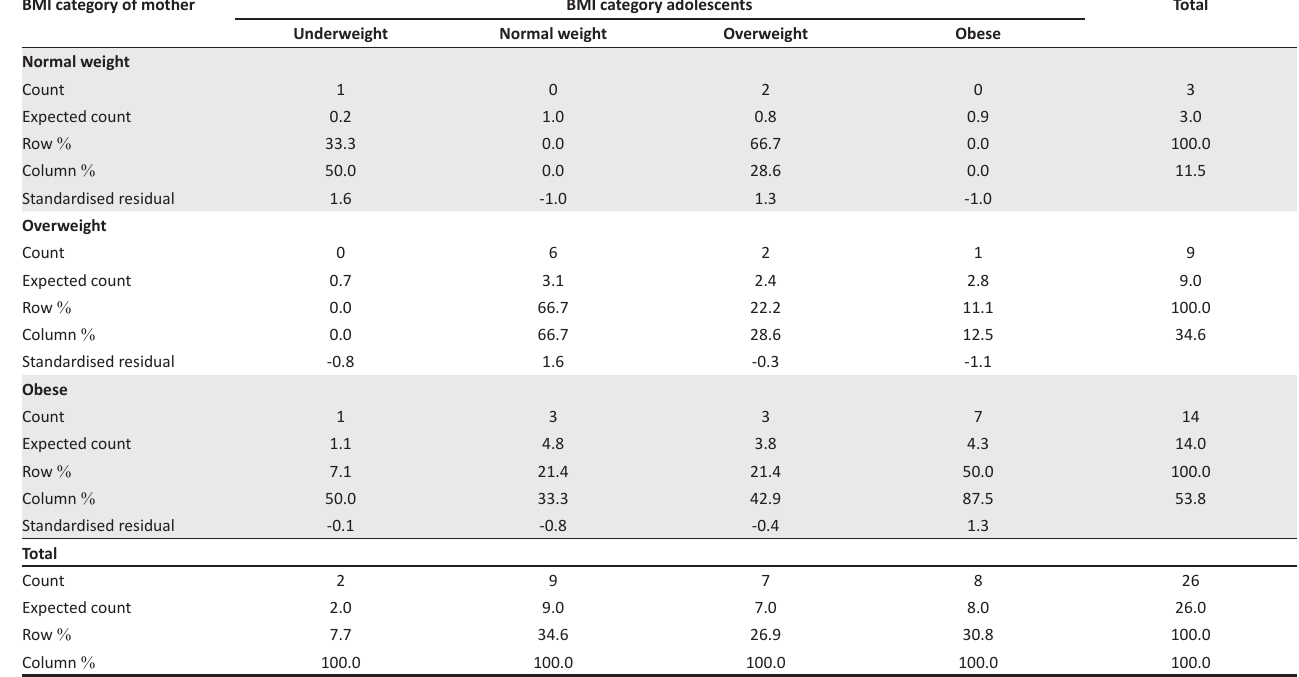
TABLE 2: Body mass index (BMI) category of mother compared with BMI category of adolescent cross-tabulation. BMI category of mother